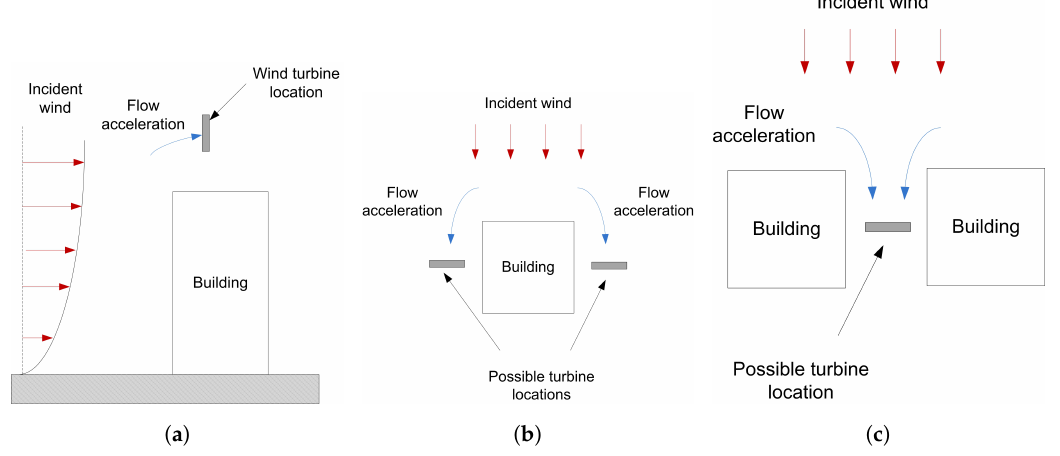
Figure 4. Possible turbine placement to exploit flow acceleration. ( a ) Roof turbine; ( b ) side façade turbine; ( c ) between